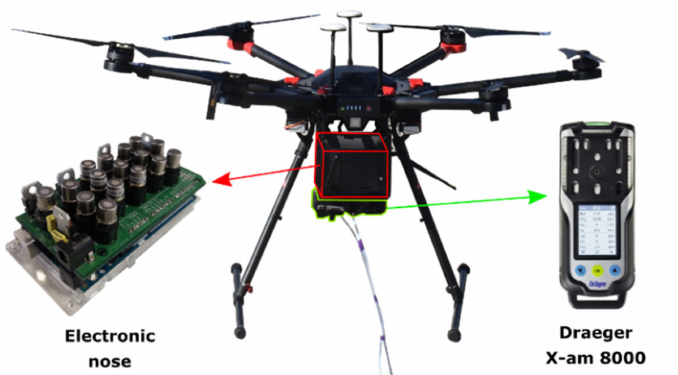
Figure 2. DJI Matrice 600 Pro drone equipped with a custom e-nose and a Dräger X-am 8000 analyzer. The inlets of both systems are connected to 10-m PTFE tubing.